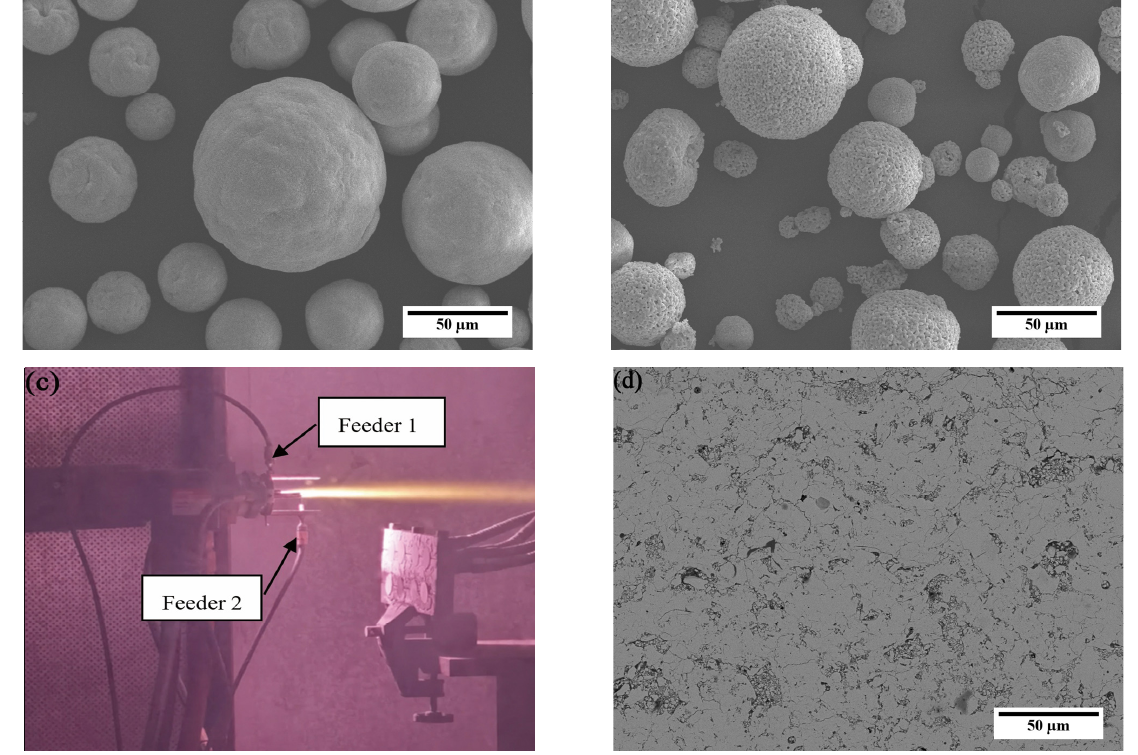
Figure 2. Coating spraying process: ( a ) Gd2Zr2O7 powder surface; ( b ) micro-aggregate Gd2Zr2O7 powder surface; ( c ) layout of equipment; ( d ) EMAP Gd2Zr2O7 coating.